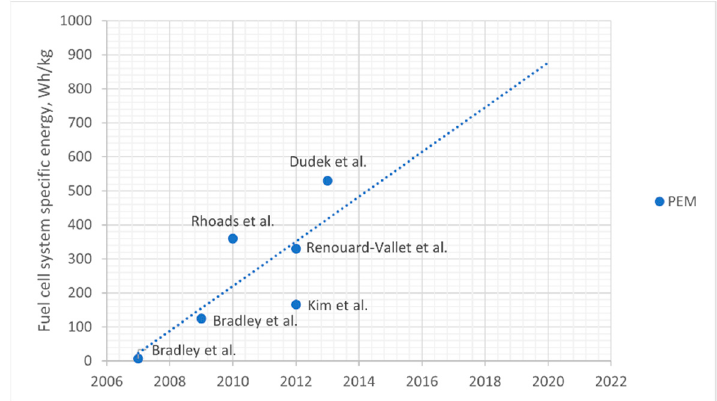
Figure 14. Specific energy of fuel cells systems for aircraft applications.